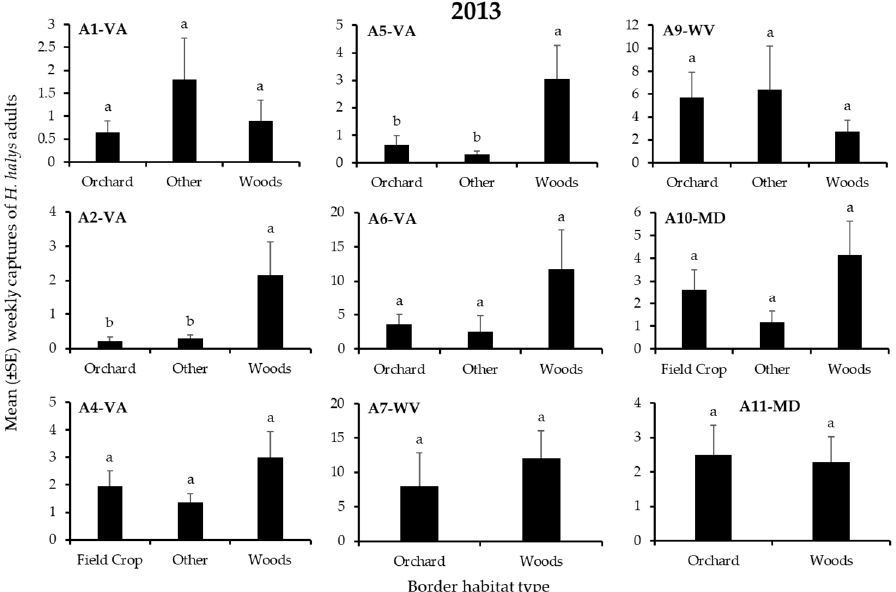
Figure 2. Mean (± SE) weekly captures of H. halys ADULTS in pheromone-baited traps on the perimeter of 9 apple orchard blocks in the Mid-Atlantic, USA, from 15 April to 10 October, 2013. Bars with shared letters are not significantly different (Tukey HSD, α = 0.05).